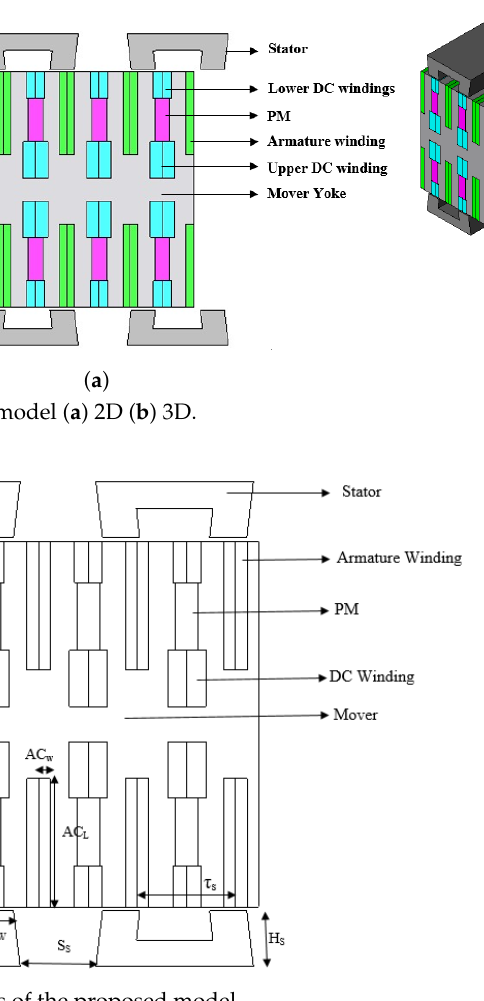
Figure 2. Parameters of the proposed